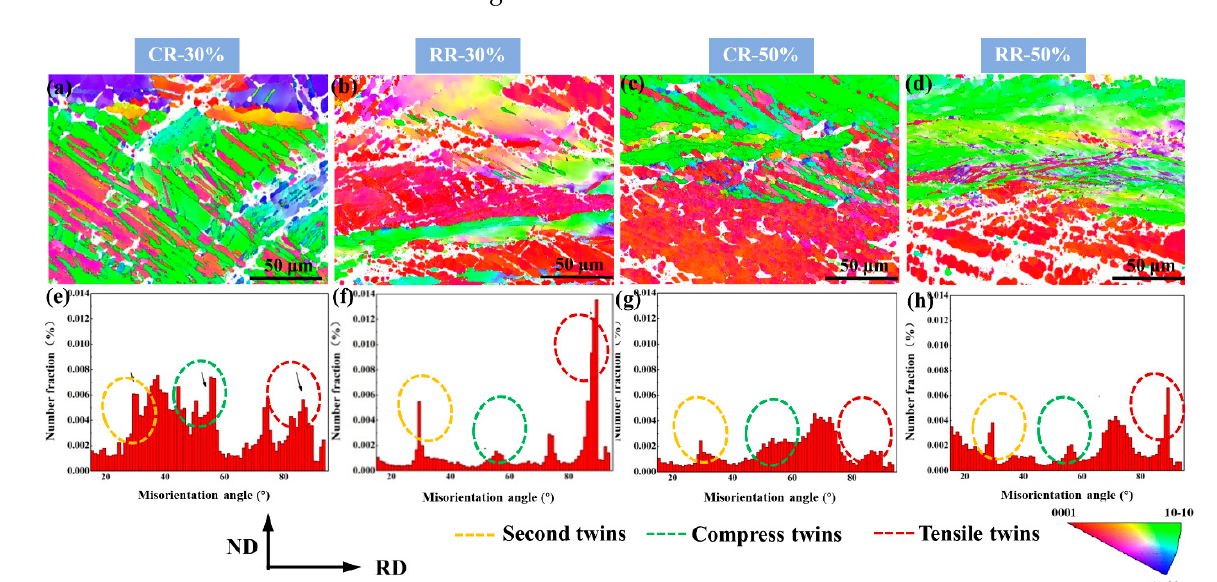
Figure 5. ( a – d ) The inverse pole figure and ( e – h ) the grain misorientation distribution diagram of CR30%, CR50%, RR30%, and RR50% plates.